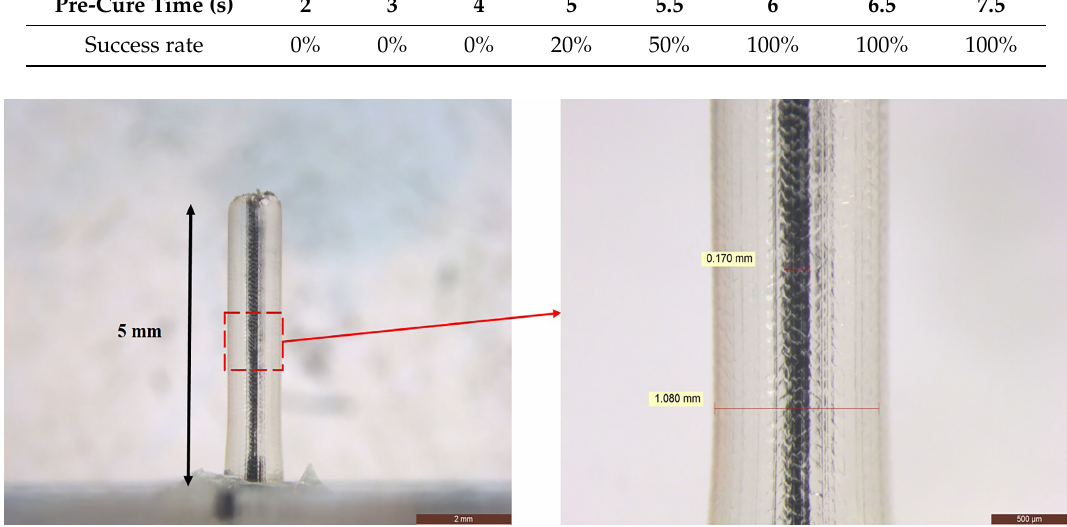
Figure 8. Dimension clarification and magnified view of successfully printed hollow